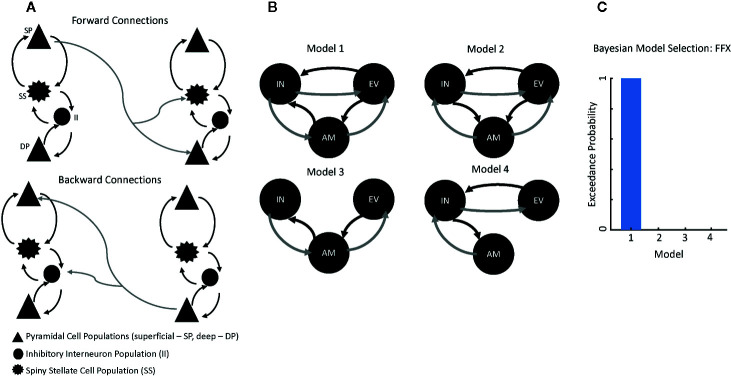
Modeling Connectivity for the Suicide Implicit Association Task (S-IAT). (A) Conductance-based neural mass model for dynamic causal modeling (DCM) for electrophysiology, which includes excitatory and inhibitory connection parameters from four distinct cell layers: superficial pyramidal cells (SPs), spiny stellate cells (SSs), deep pyramidal cells (DPs), and inhibitory interneurons (IIs). Forward connections originate from SPs to both SSs and DPs. Backward connections originate from DPs to both SPs and IIs. (B) Four plausible models were constructed to account for message-passing between early visual cortex, amygdala, and insula. (C) Results from Bayesian model selection to adjudicate between the four models; the strongest evidence was found for Model 1, which had fully reciprocated forward and backward connections between each region of interest.